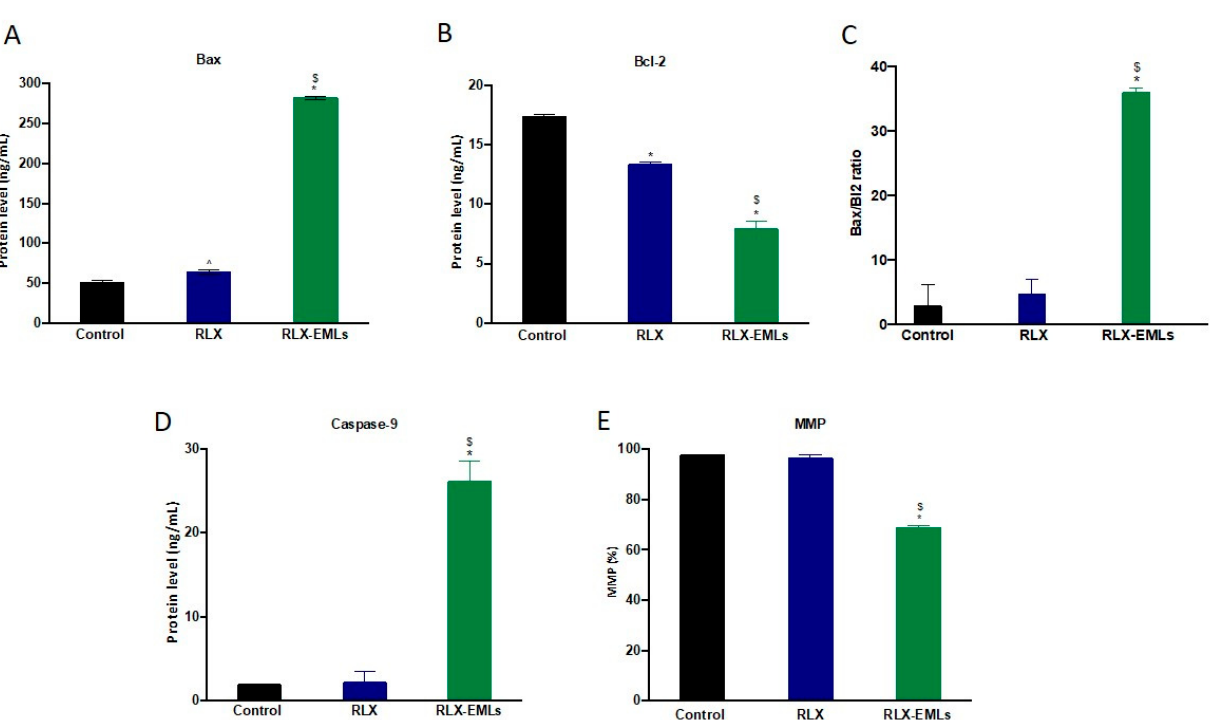
Figure 5. Effect of RLX-EMLs or RLX on Bcl-2 proteins, caspase-9 activation and MMP. ( A , B ) protein levels for BAX and Bcl-2 consequently. ( C ) Bax/Bcl-2 ratio. ( D ) activation level of caspase-9. ( E ) percentage of MMP. All data are expressed as the mean ±SE of three independent experiments. * P < 0.0001 considered significantly different from the control. $ P < 0.0001 considered significantly different from RLX.